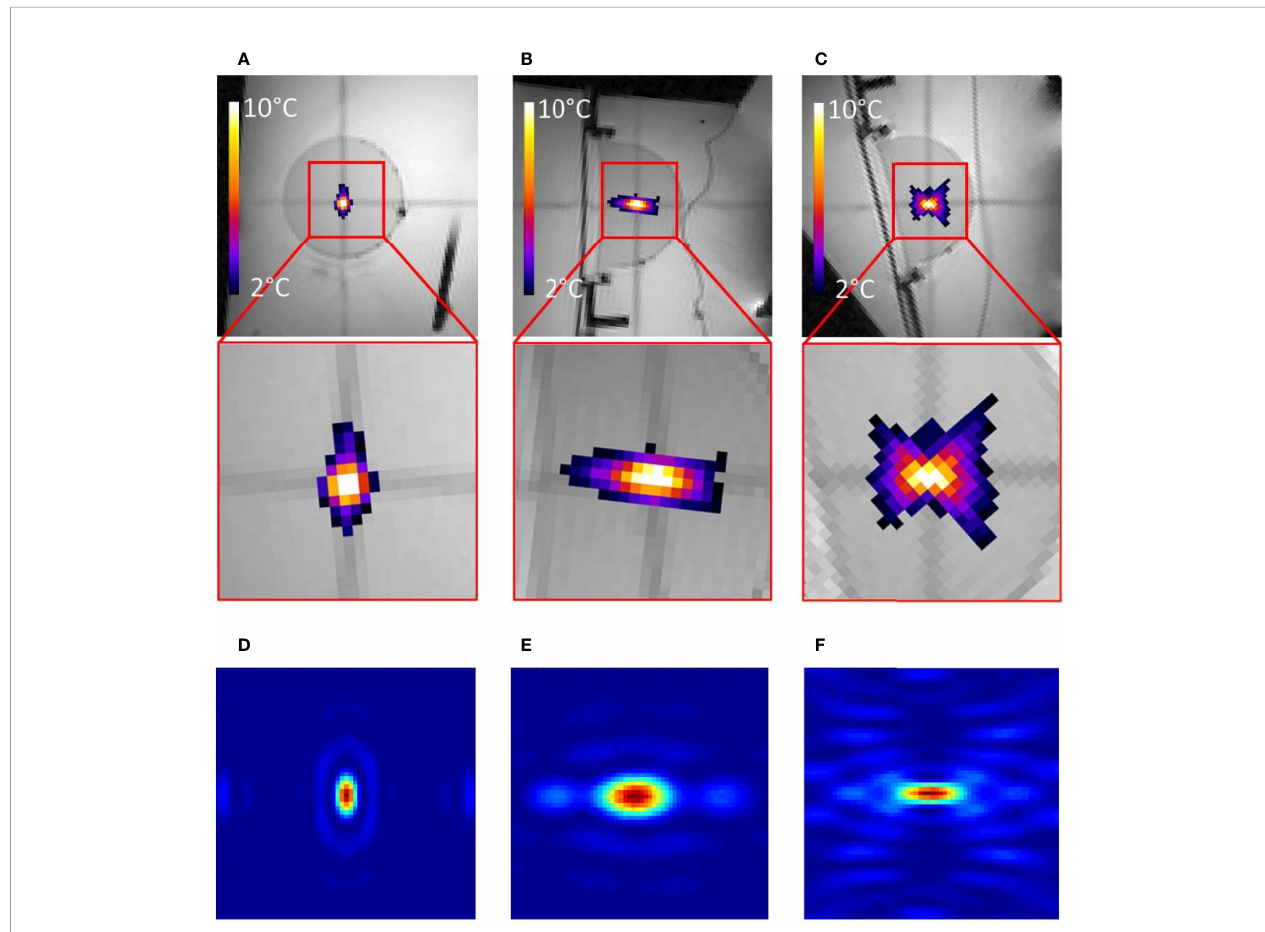
FIGURE 3 | (A – C) MR images of the gel phantom merged with proton frequency resonance shift (PRFS) thermal maps in three orthogonal planes, during a 10-s HIFU sonication. The inset FOV is 55 mm and a color bar is provided for the temperature elevation. (D – F) Numerical calculation of acoustic intensity in three orthogonal planes; linear color scale; the FOV is 18